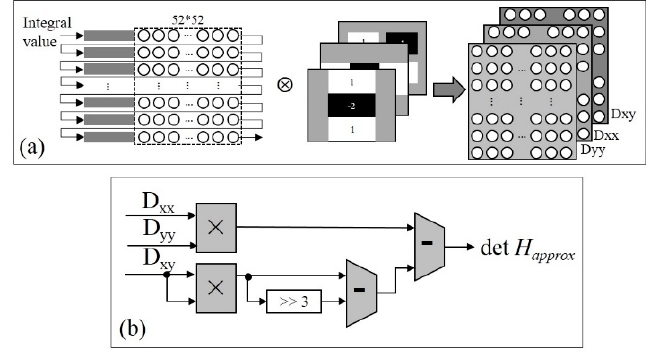
Figure 6. ( a ) Parallel computation of D xx , D yy , and D xy in different scales; ( b ) FPGA implementation of determinant of Hessian matrix.